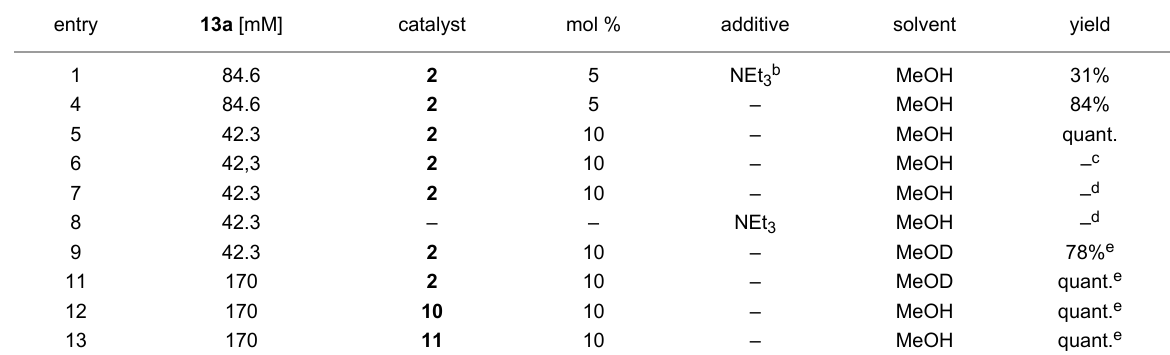
Table 2: Screening of reaction conditions for the methanol addition to α -methylstyrene ( 13a ). a